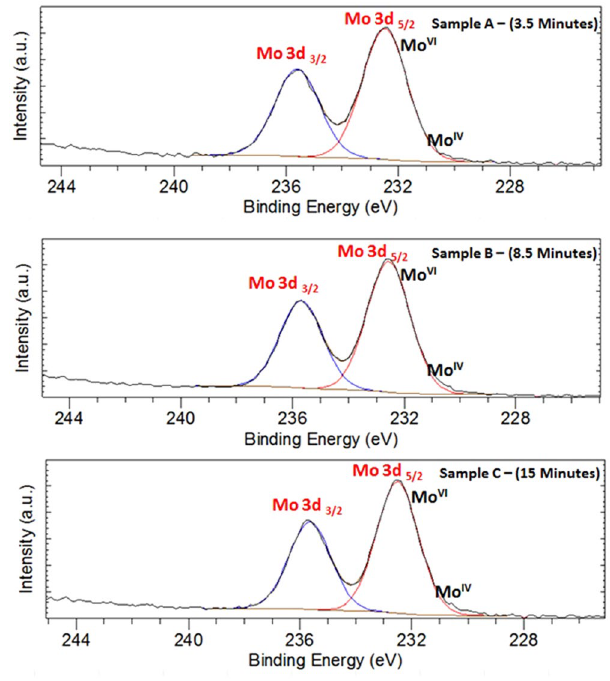
Figure 20. Mo 3d XPS spectra for samples picked up at ( a ) 3.5 minutes, ( b ) 8.5 minutes, and ( c ) 15 minutes after starting of the reaction.